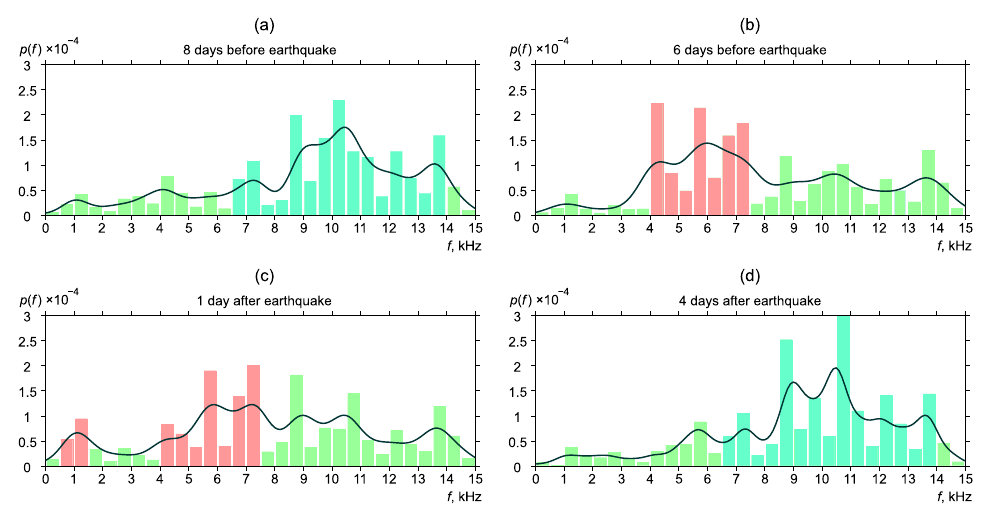
Figure 6. Dynamics of the probability density of distribution of the most powerful frequencies of geoacoustic pulses before and after the earthquake No. 1. p ( f ) is the frequency density. A similar distribution of frequencies was observed in the case of earthquake No. 2.